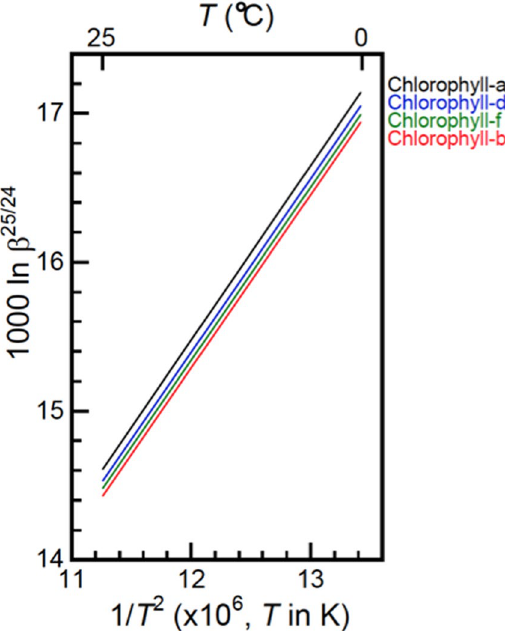
Figure 2. Temperature dependence of ln β . The ln β 25/24 values of chlorophyll a, b, d, and f calculated by using O3LYP/6-31G(d) are shown as linear functions of T − 2 .